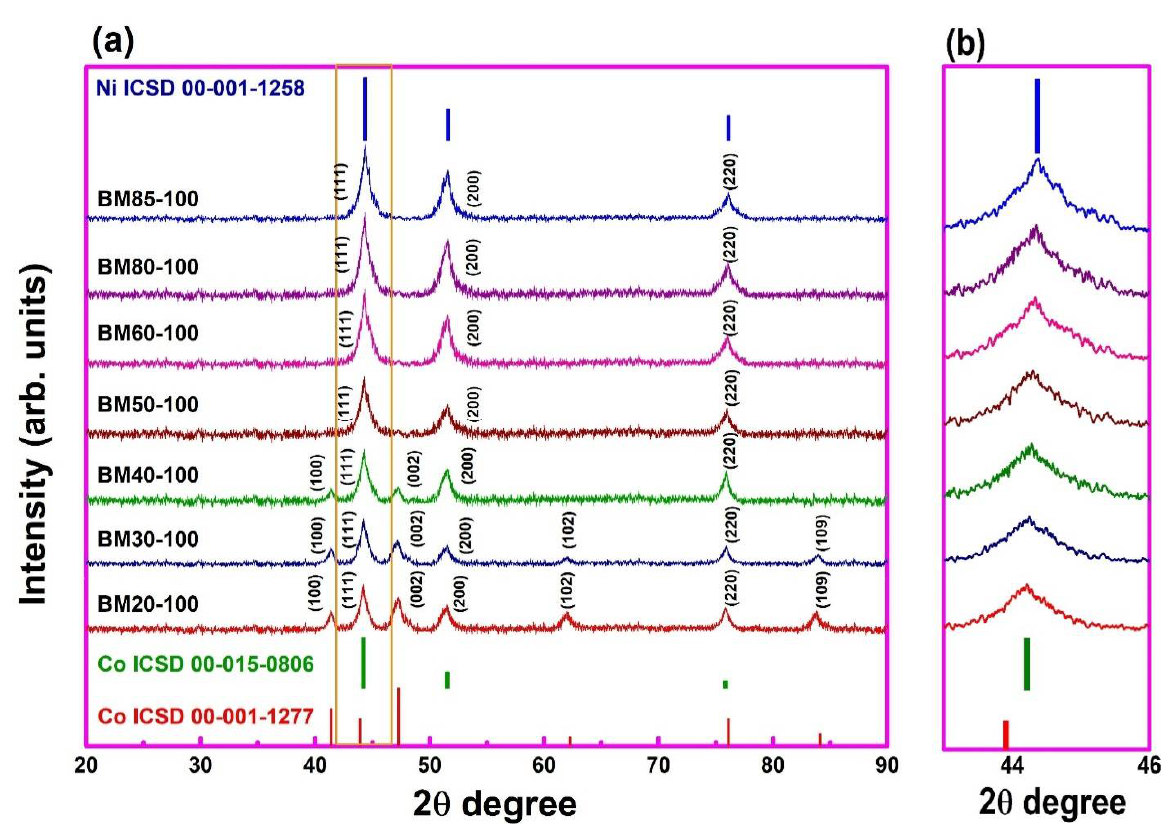
Figure 1. ( a ) XRD spectra of ball-milled Co 100−x Ni x (x = 20, 30, 40, 50, 60, 80, 85) NPs at 1425 rpm for 100 min ( b ) The evolution of the (111) reflection in more detail. The base panels show the reference spectra for Co using the reference data (ICSD 00-001-1277) and (ICSD 00-015-0806). The uppermost panels show the reference spectra for Ni (ICSD 00-001-1258).